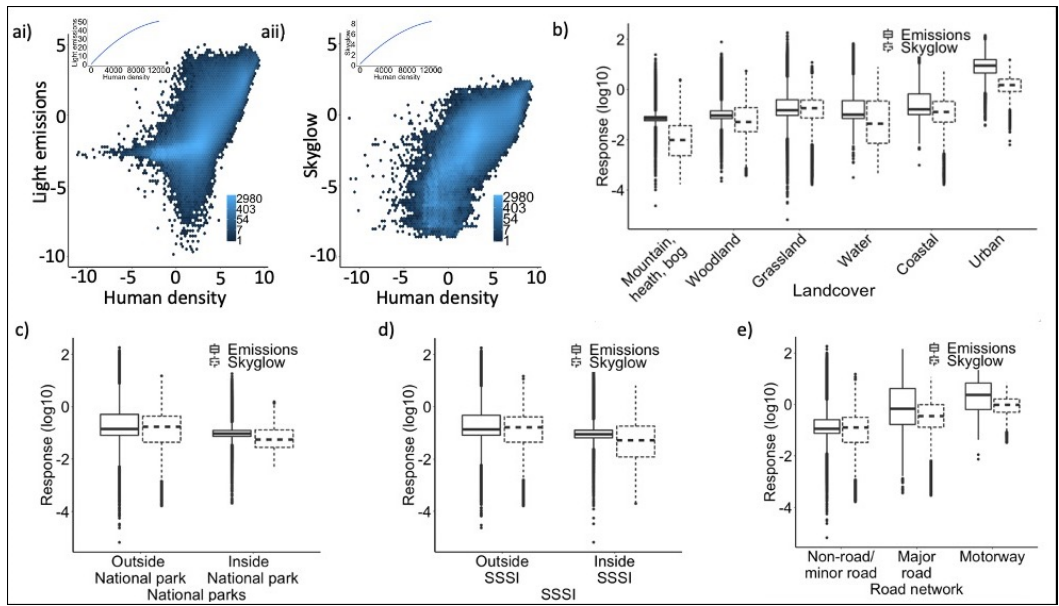
Figure 3. The relationship between ( i ) light emissions and ( ii ) skyglow with ( a ) human density (logged), ( b ) landcover, ( c ) National Parks, ( d ) SSSI, and ( e ) roads. ( a ) gives the logged values for light emissions and skyglow, while ( b – e ) show both values at log10. The legend for ( a ) shows the log of the number of pixels, and the plot in the top left of the panels illustrates the asymptotic relationship. Boxplots ( b – e ) show the median, the lower and upper quartiles and the minimum and maximum values, and the legend denotes whether the data illustrates the relationship with light emissions (solid line) or skyglow (dashed line).